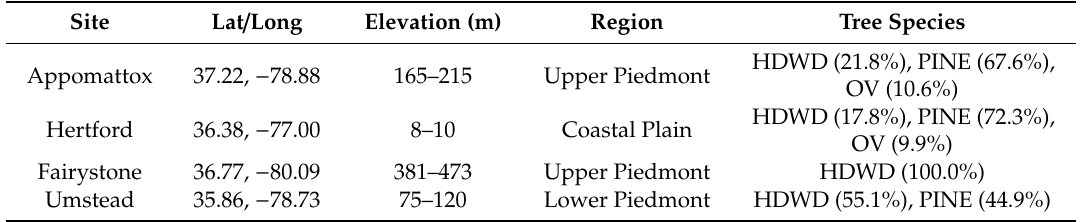
Note: HDWD—“hardwood”, OV—“other vegetation”. Table 2. Forest composition and biometrics for the four LAI research sites. Table 2. Forest composition and biometrics for the four LAI research sites.